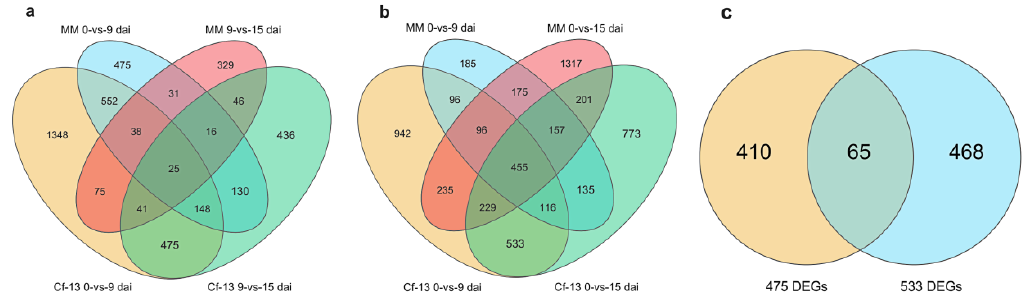
Figure 4. Venn diagrams of the different groups of DEGs. ( a ) Venn diagram of DEGs among the MM 0 vs. 9 dai, MM 9 vs. 15 dai, Cf-13 0 vs. 9 dai, and Cf-13 9 vs. 15 dai comparisons. ( b ) Venn diagram of DEGs among the MM 0 vs. 9 dai, MM 0 vs. 15 dai, Cf-13 0 vs. 9 dai, and Cf-13 0 vs. 15 dai comparisons. ( c ) Venn diagram of the 475 DEGs and 533 DEGs comparison (MM 0 vs. 9 dai, MM 9 vs. 15 dai, MM 0 vs. 15 dai, Cf-13 0 vs. 9 dai, Cf-13 9 vs. 15 dai, and Cf-13 0 vs. 15 dai). Cf-13 and MM tomatoes were inoculated with C. fulvum and sampled at 0, 9, and 15 dai. 475 DEGs: the common genes differentially expressed between 0 – 9 dai and 9 – 15 dai only in Cf-13 ; 533 DEGs: the common genes differentially expressed between 0 – 9 dai and 0 – 15 dai only in Cf-13 .